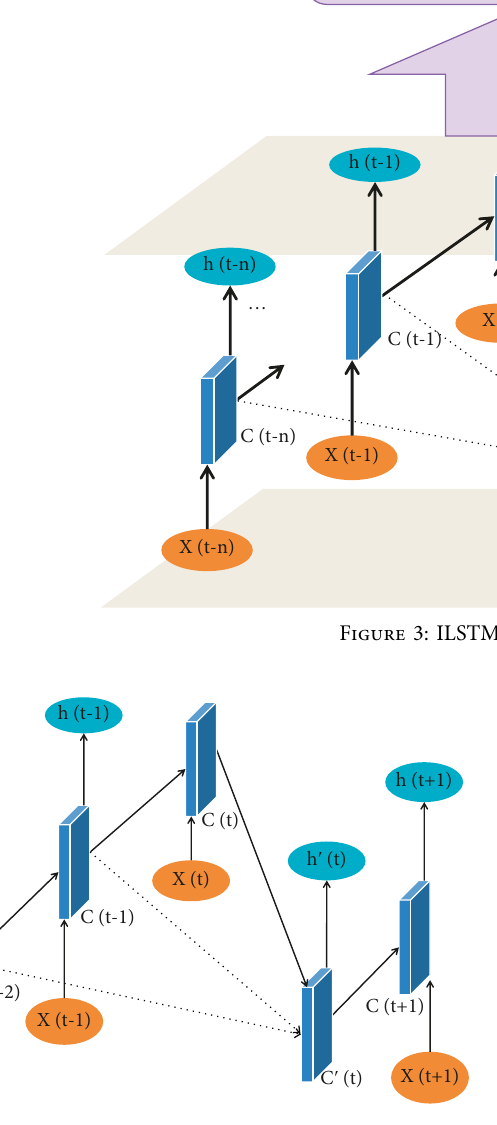
Figure 4: Improved LSTM structure